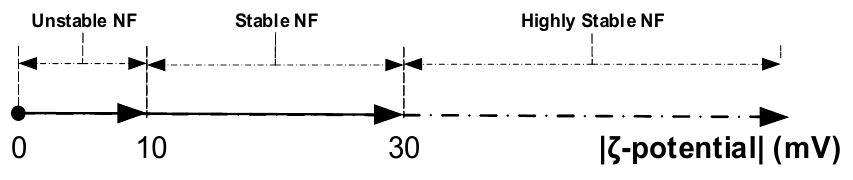
Figure 2. Significance of zeta potential values.